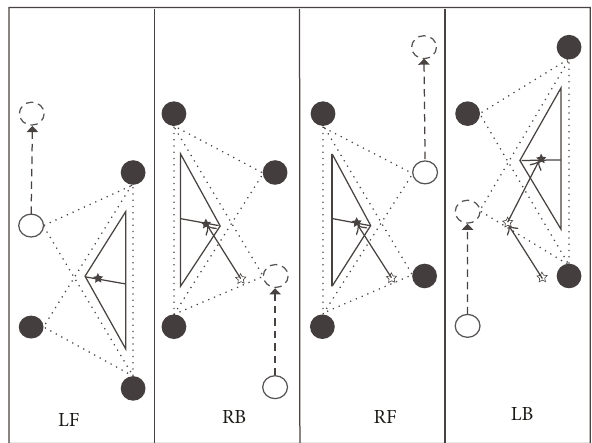
Figure 3: Nominal static gait pattern of one circle.